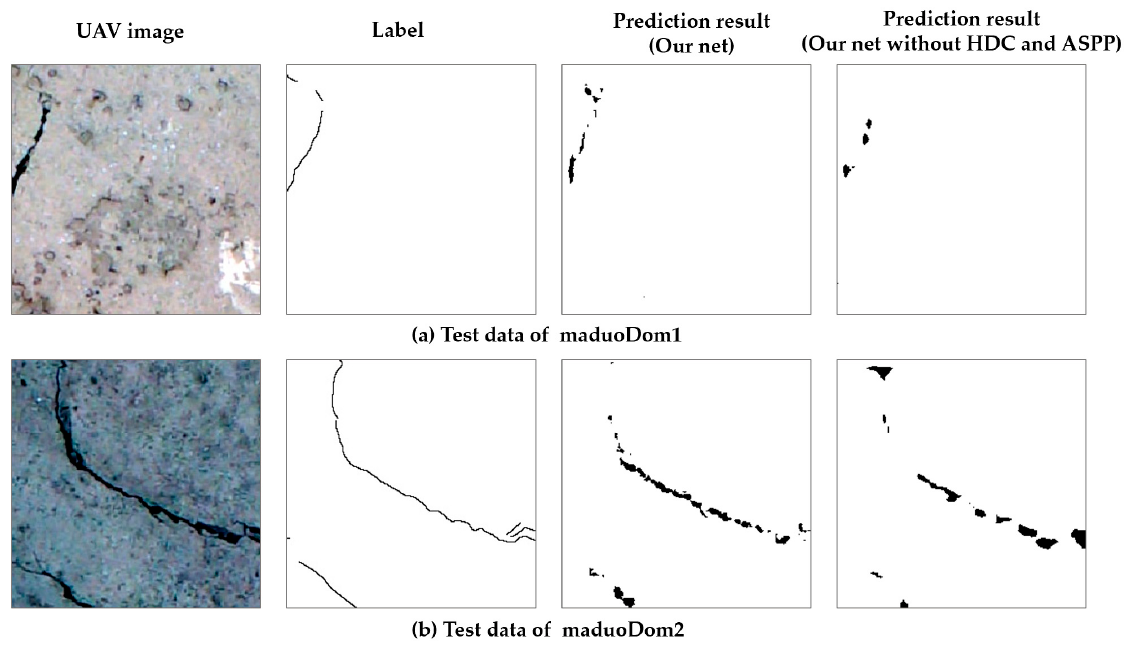
Figure 8. Prediction results of different network architectures for maduoDom1 and maduoDom2.